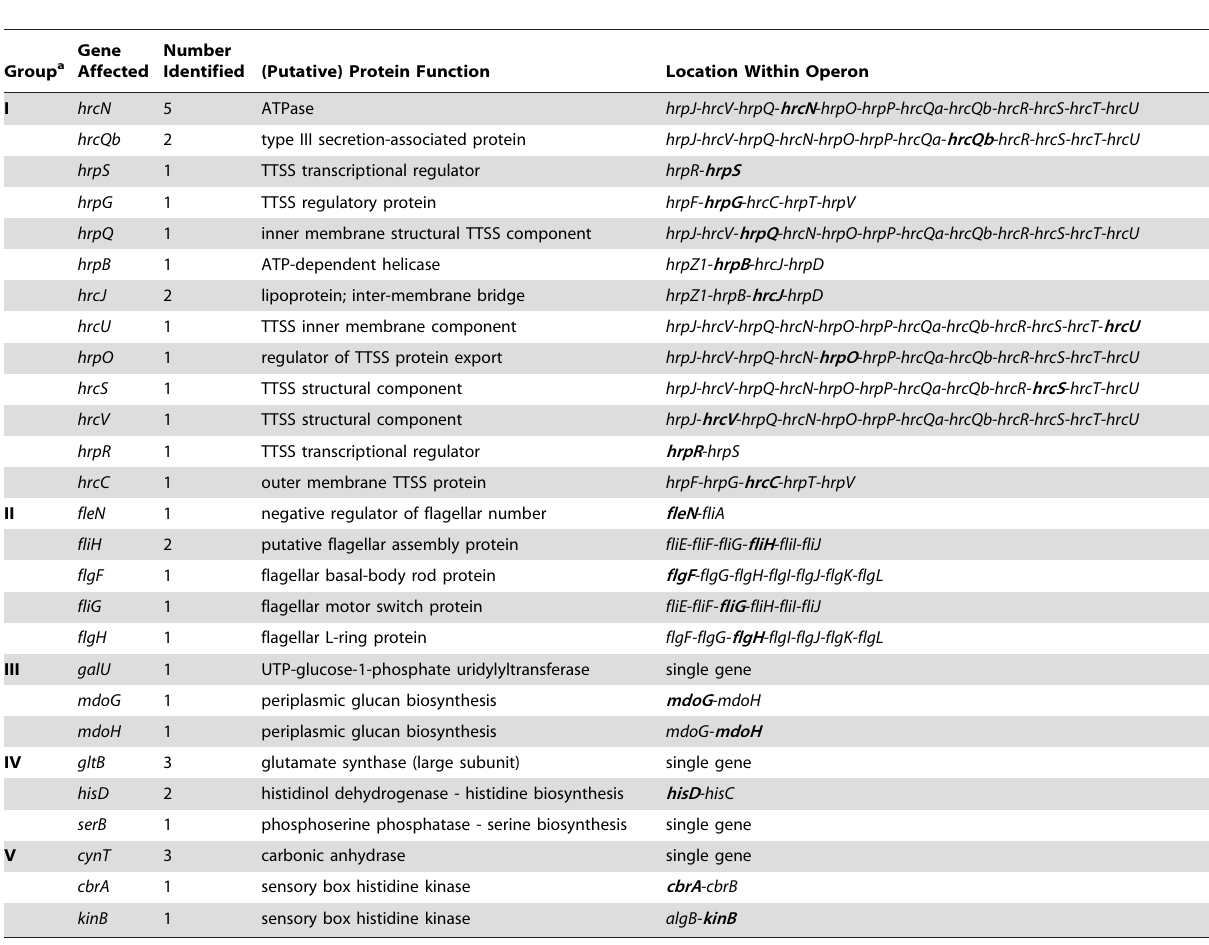
Table 1. Pseudomonas syringae pv. maculicola ES4326 transposon disruptants with reduced virulence in a high-throughput liquid media-based